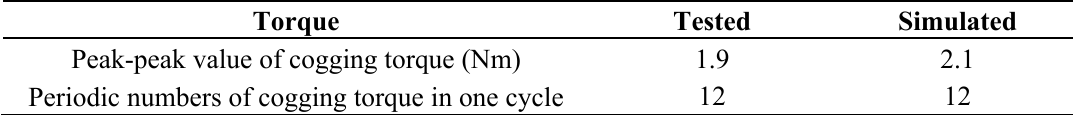
Table 2. Tested and simulated cogging torque between PM rotor and claw pole